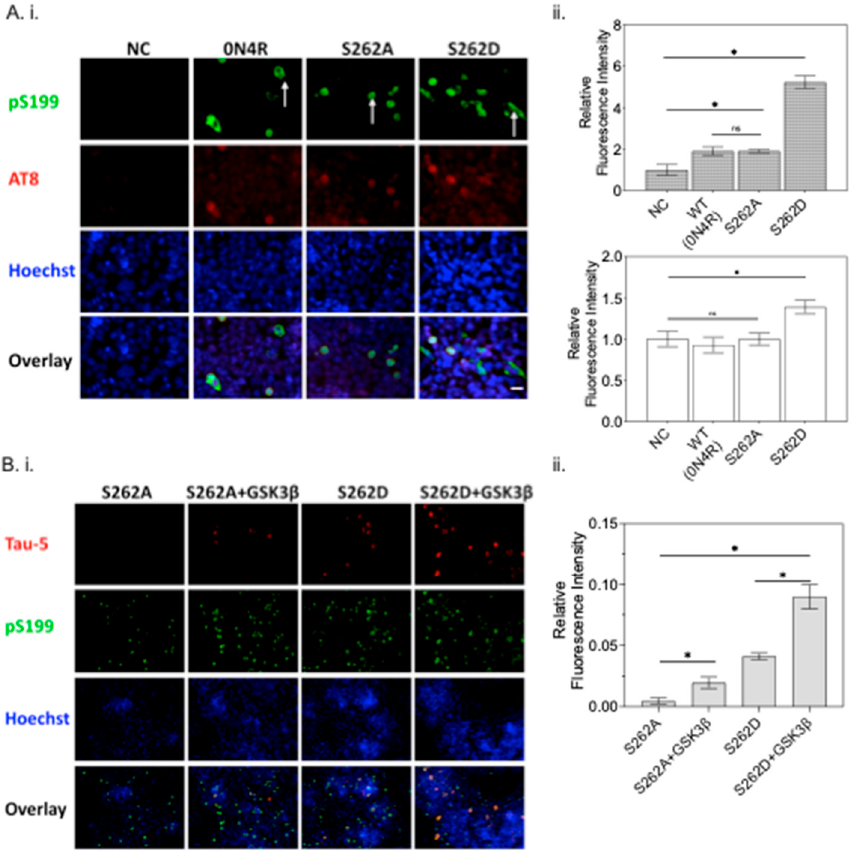
Figure 9. The interplay between Ser262 phosphorylation and GSK3 β activity. ( A ( i )) Expression of phosphorylated tau at Ser199 (pS199, Green) and Ser202/Thr204 (AT8, Red) in CHO cells transfected with wild type 0N4R tau, S262A variant, or S262D variant. NC: CHO cells only. Scale bar = 25 µ m. Arrows indicate the differential cellular localization of pS199 expressed by transfected cells. ( A ( ii )) The intensity of pS199 and AT8 immunostaining in CHO cells transfected with different constructs were normalized by Hoechst staining levels with NC set arbitrarily at 1. (* represents p < 0.05 between two different groups, n = 3; ns = not significant). ( B ) The effect of Ser262 phosphorylation on the activity of GSK3 β was further examined by co-transfecting tau and GSK3 β plasmids. The expression of total tau (Tau-5, Red) is shown in ( B ( i )). (Scale bar = 25 µm.) and quantified ( B ( ii )). for comparison between different groups (* represents p < 0.05 between two different groups, n = 3; ns = not significant).